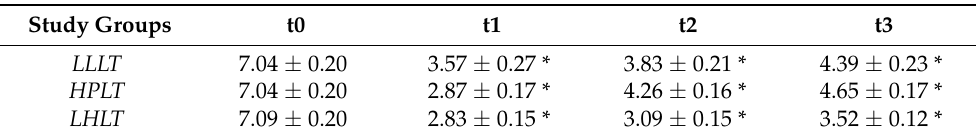
Table 2. The mean and the standard error of the VAS score are shown at each time point (t0, t1, t2, and t3) for each study group. LLLT: Low-Level Laser Therapy; HPLT: High-Power Laser Ther- apy; LHLT: Low–High combined Laser Therapy; CW: Continuous Wave * = p -value of Wilcoxon test < 0.0001, comparison performed with the mean VAS score at t0. The bold text shows the signifi- cant p -value obtained with the Wilcoxon text by comparison of the mean VAS score between t1 and t2 and between t2 and t3.